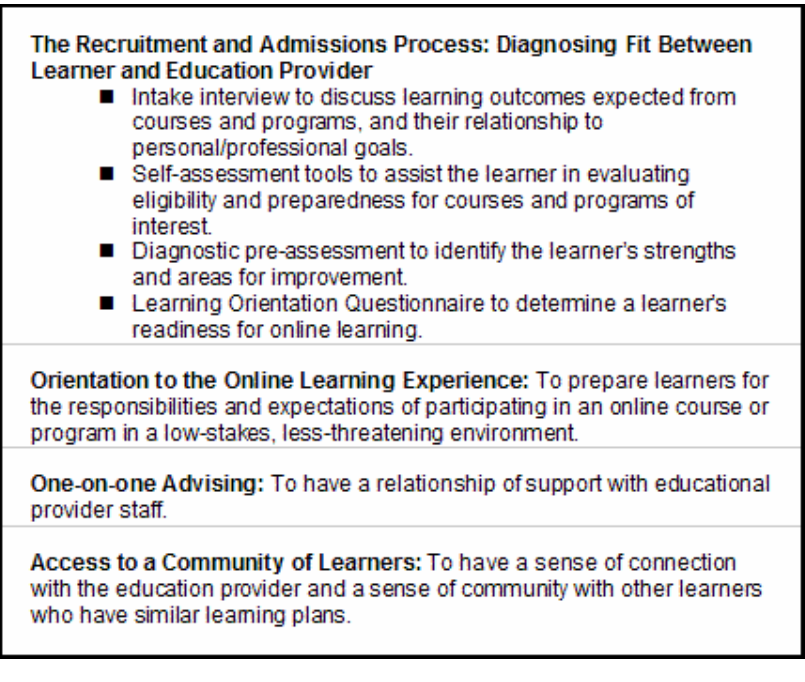
Table 1 . Learner Support Services Strategies for Self-direction and